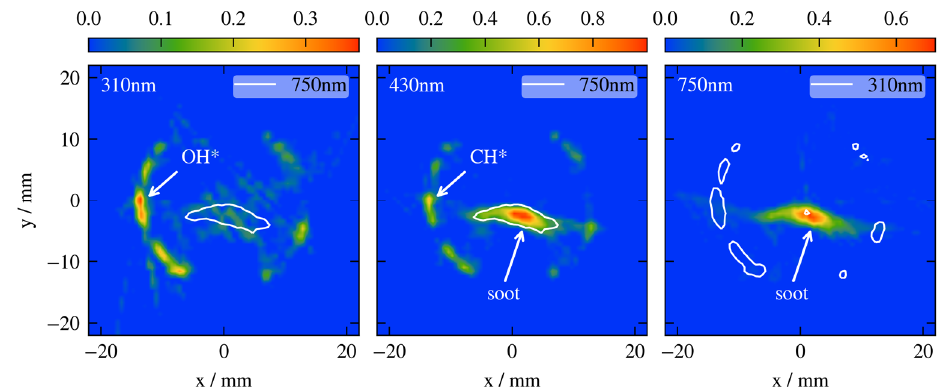
Figure 14. Simultaneously acquired, normalized distributions at 310 nm (OH*, left), 430 nm (CH* + soot, middle) and 750 nm (soot, right) measured at a turbulent ethylene / air di ff usion flame 4 mm above the burner with an exposure time of 1 ms ( λ 1 = 5, λ 2 = 5, C 2 H 4 2 slm, air 100 slm). The white solid lines are the 25% isolines of distributions at 750 nm (left and middle) or 310 nm